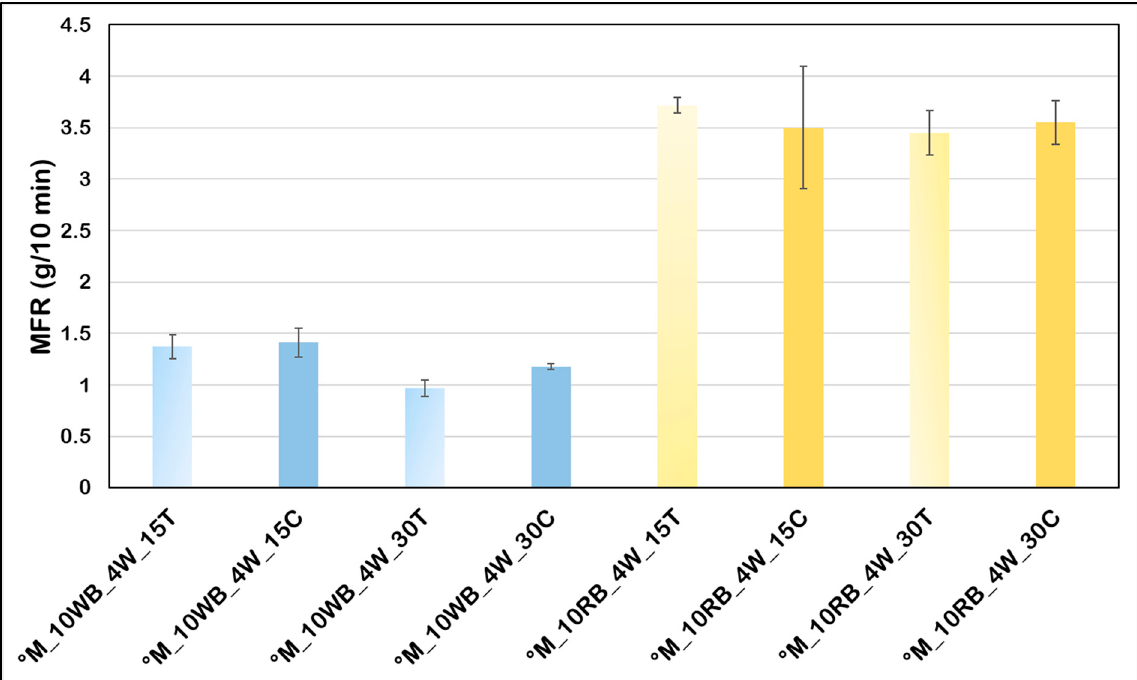
Figure 5. Melt flow rate behavior inserting 10 wt.% of coated fibers with different amounts of particulate mineral fillers.